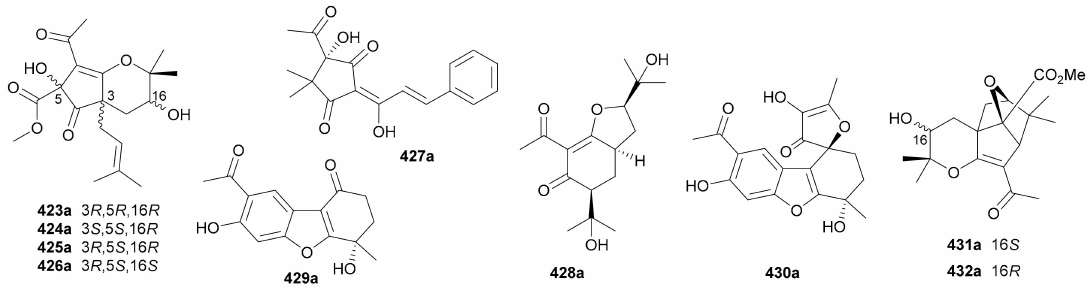
Figure 24. Structures of acetophenones.